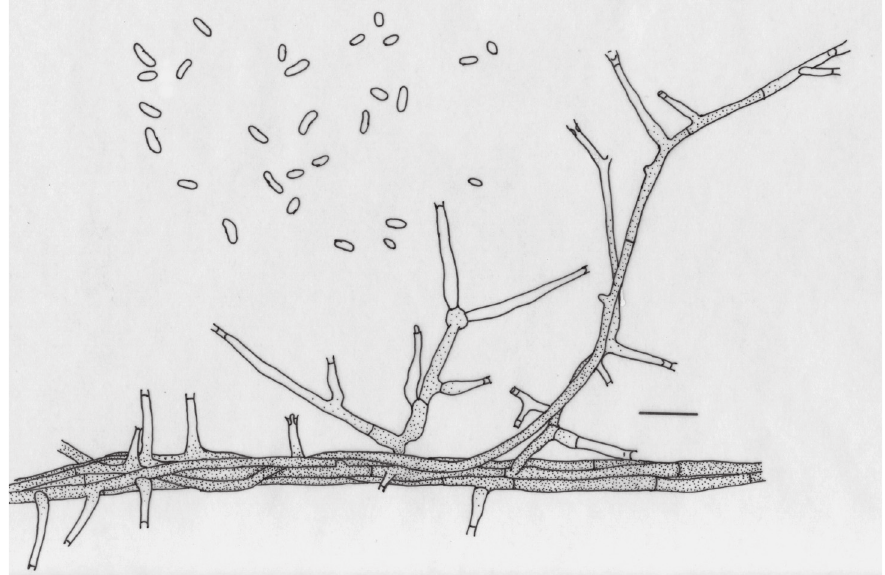
Fig. 4. Togninia minima. Phaeoacremonium aleophilum anamorph, grown on PDA for 2 weeks at 25°C (scale bar 10